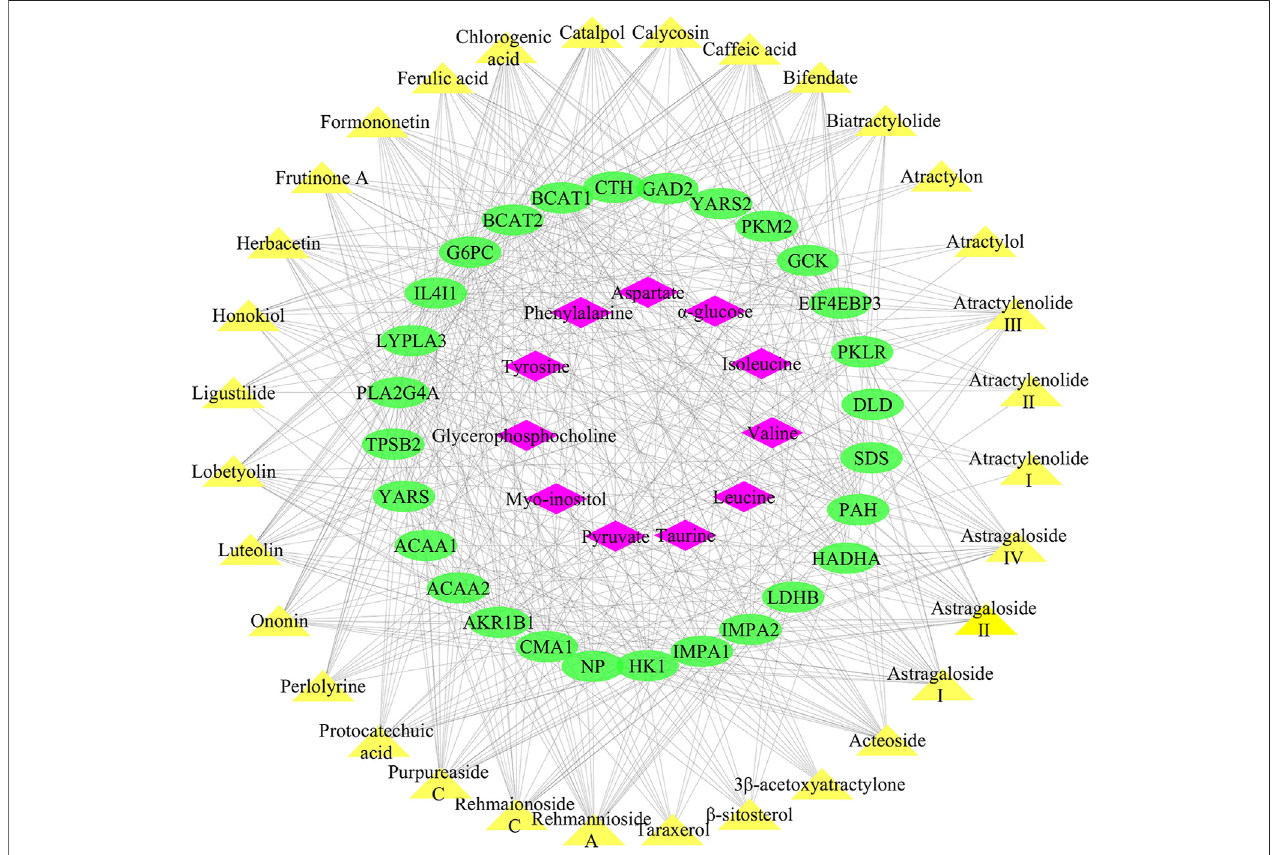
FIGURE 7 | “ Active ingredients-targets-differential metabolites ” regulatory network of LBG. Yellow nodes represent the active ingredients, green nodes represent the targets, and pink nodes represent differential metabolites.